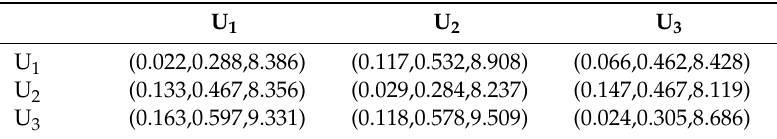
Table 15. The fuzzy total influence matrix.